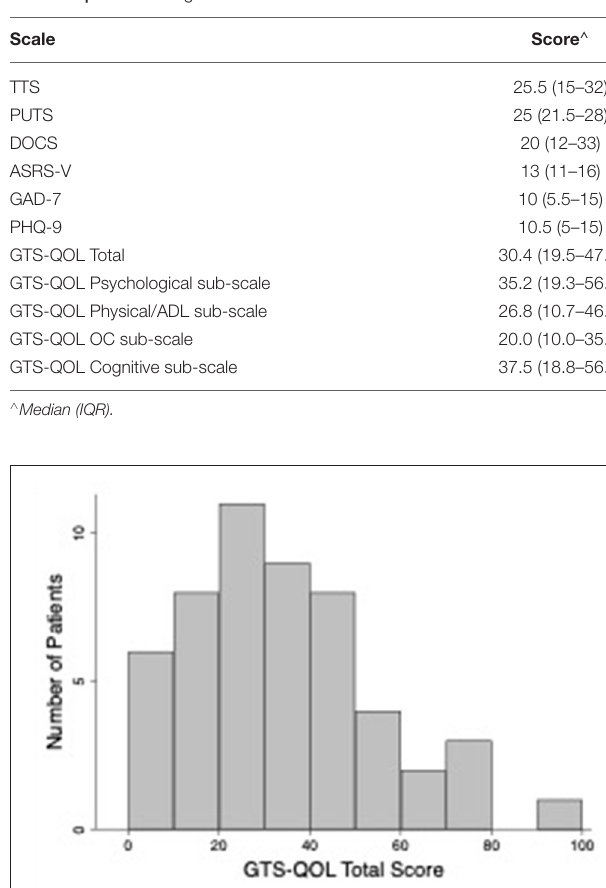
TABLE 2 | Cohort clinical characteristics. TABLE 3 | Clinical rating scale scores.